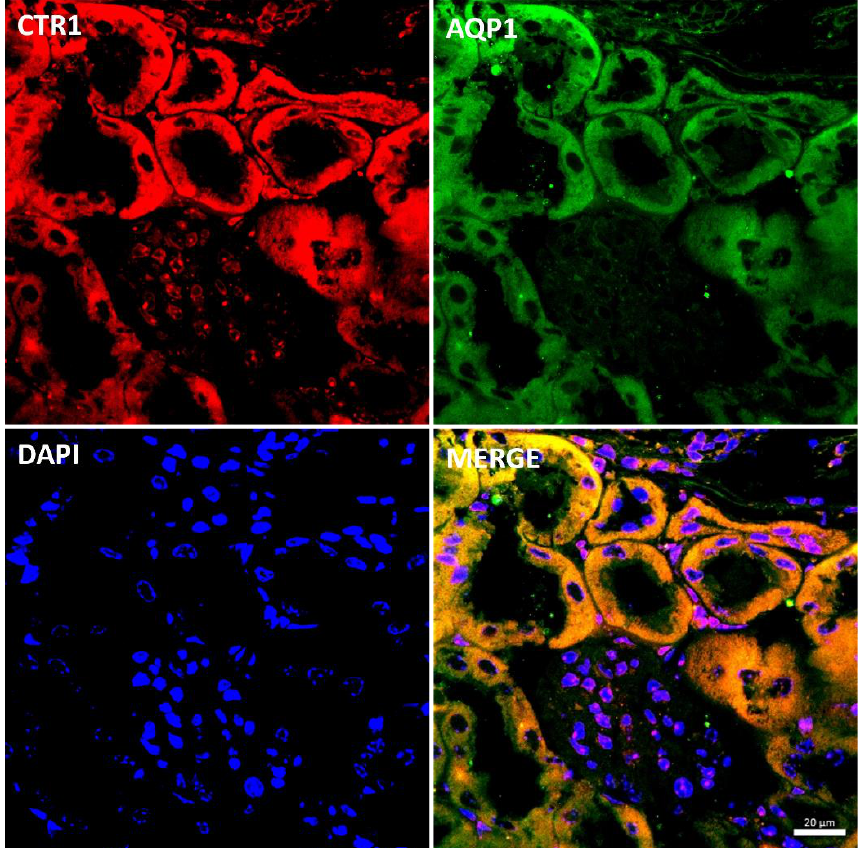
Figure 8. Colocalization CTR1 (red channel) and aquaporin1 (AQP1), a proximal tubule marker (green channel) in the kidneys of adult (6-month-old) w-t mouse analyzed by confocal microscopy. Nuclei were counterstained with DAPI. Bars correspond to 20 μm.